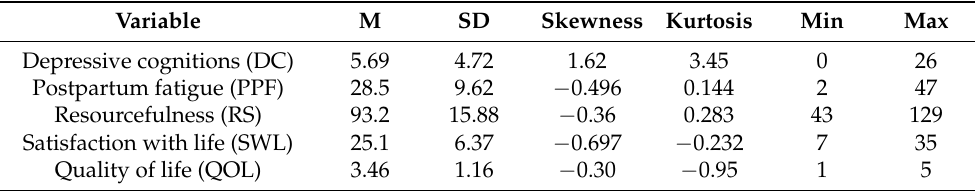
Table 2. Descriptive Statistics for the Composite Scores of the Scales. Variable